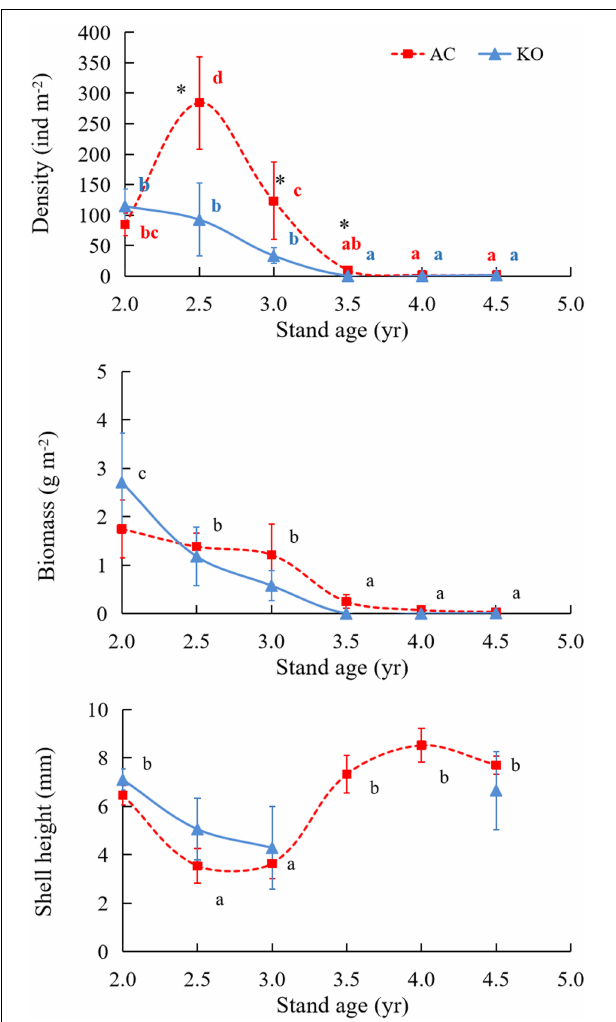
FIGURE 4 | Size distributions of the Mainwaringia leithii specimens collected in the two mangrove sites and the relationship between the shell height and fresh weight of the